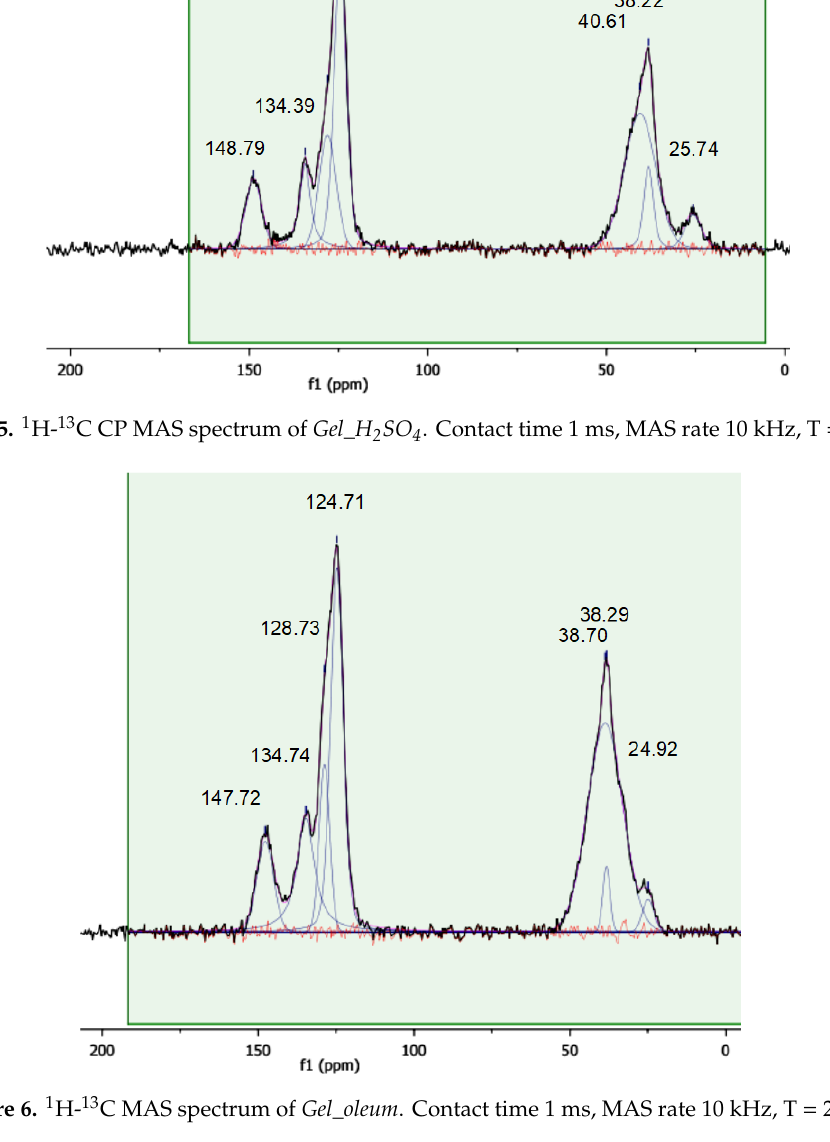
Figure 6. 1 H- 13 C MAS spectrum of Gel_oleum . Contact time 1 ms, MAS rate 10 kHz, T = 25 °C.